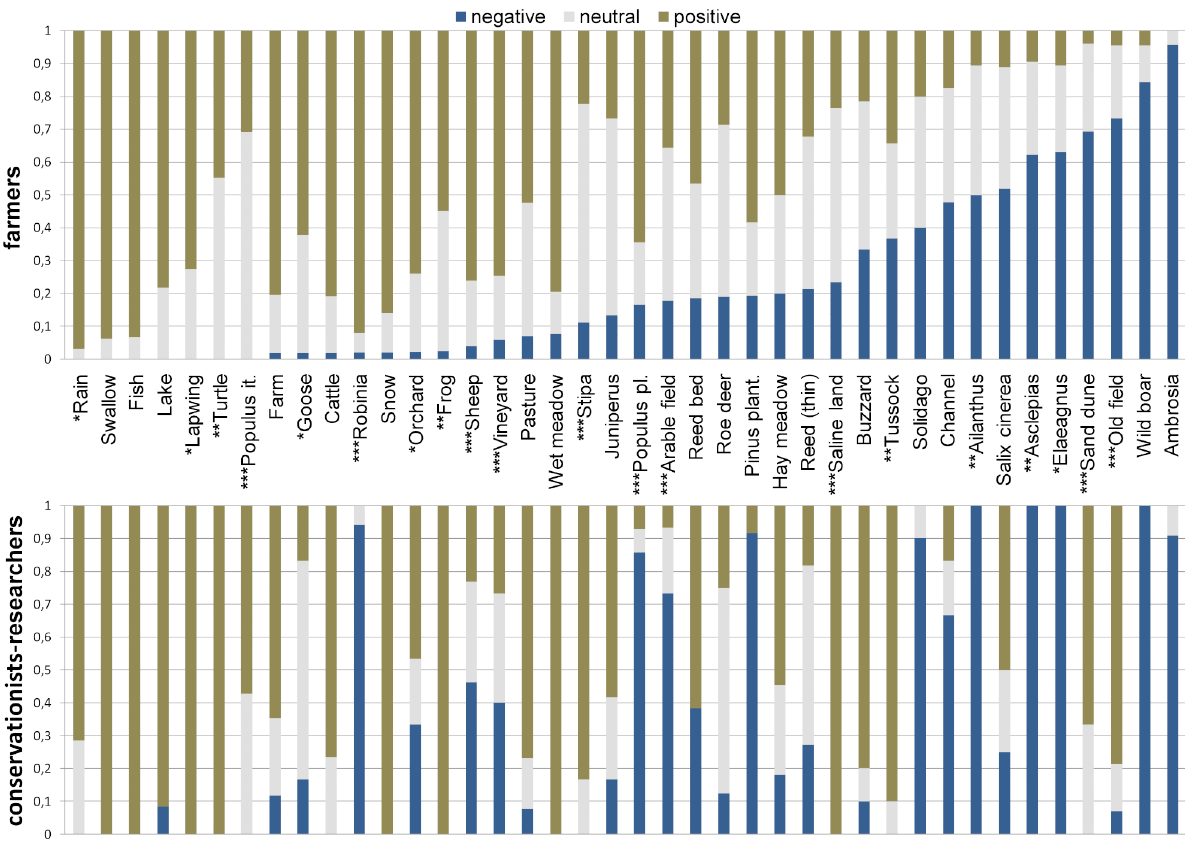
Fig. 4 . Evaluation of landscape elements by farmers and conservationists-researchers, based on the calculation of perceived trends and opinions: evaluation = trend × opinion (Mann-Whitney test, * < 0.05; ** < 0.01; *** <